Question: What style of plot is this figure drawn as?
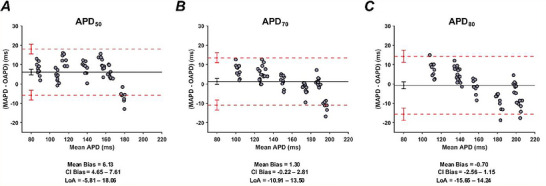
Answer: bar